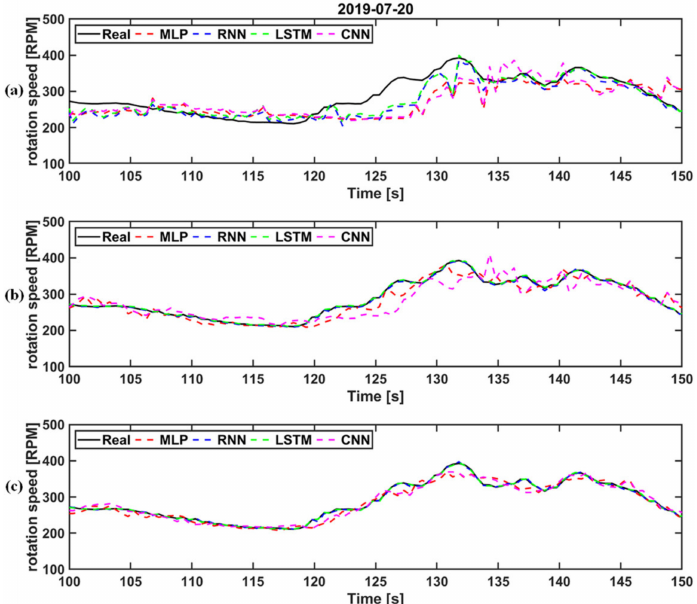
Figure 15. Comparison of amplified prediction performances as a function of the number of input datasets for each algorithm (20 July 2019): ( a ) the two datasets with the highest correlation; ( b ) six datasets with high correlation; and ( c ) all training